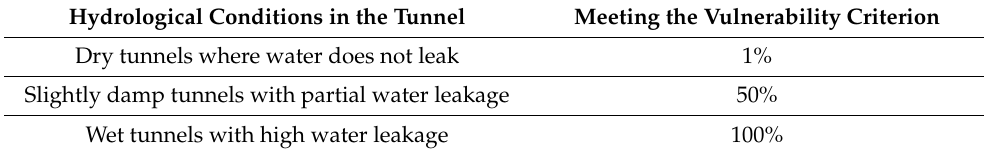
Table 13. Hydrological Condition in the Tunnel. Hydrological Conditions in the Tunnel Meeting the Vulnerability Criterion